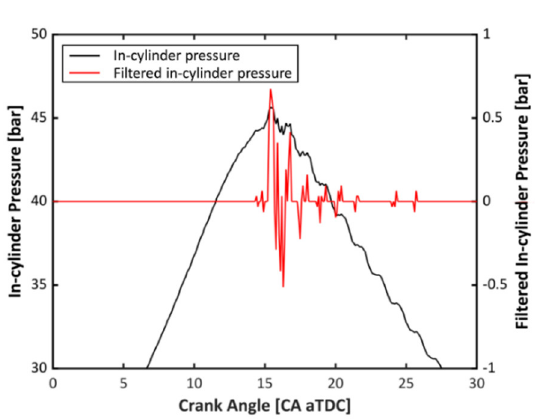
Figure 2. Filtering of in-cylinder pressure signal under knocking condition. aTDC: After top-dead center.